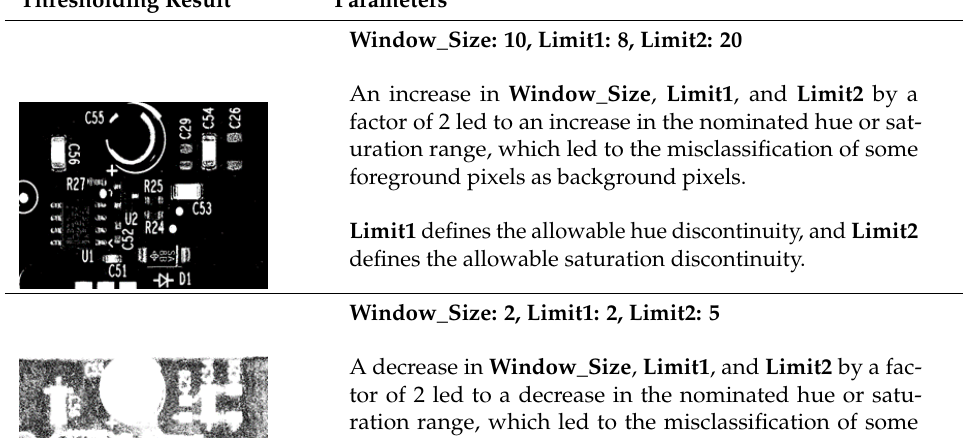
Table A4. Cont. Thresholding